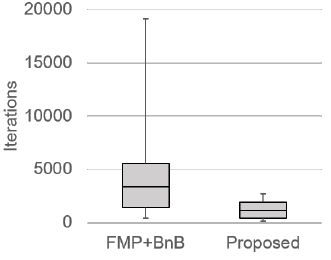
Figure 7. Number of iterations for Arch dataset Trees dataset: